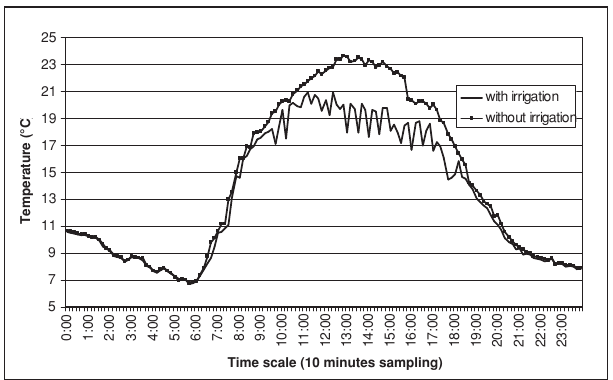
0102030405060708090100 042010 062010 202010 222010 162010 182010 302010 022010 082010 102010 142010 282010 122010 242010 262010 04 . 04 . 04 . 04 . 04 . 05 . 05 . 04 . 04 . 05 . 05 . 05 . 04 . 04 . 05 . 05 . . . . . . . . . . . . . . . . 2010 . Figure 7. The effect of irrigation on the blooming dynamic of apple. Between April 14 and May 14, 2010